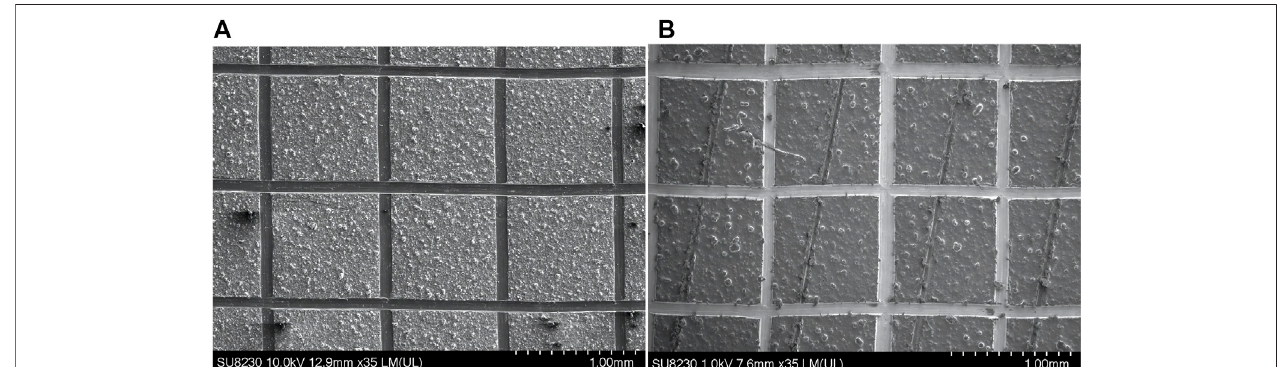
FIGURE 8 | Adhesion test. SEM image of the cross-cut test for the (A) A020 coating and (B) A021 coating.